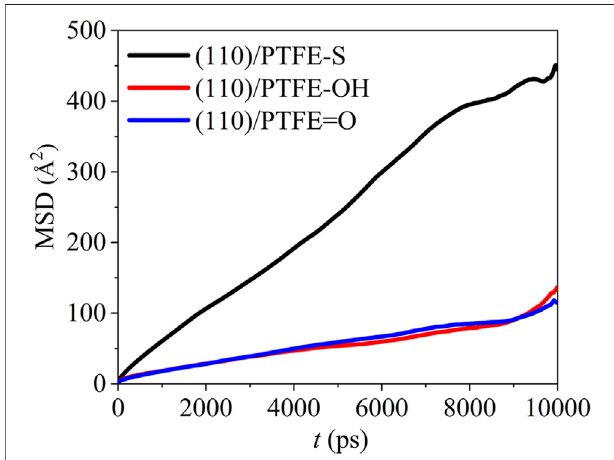
FIGURE 9 | Mean square displacement of polymer molecules in the (110)/PTFE (cid:2) O, (110)/PTFE-OH, and (110)/PTFE-S interface systems.